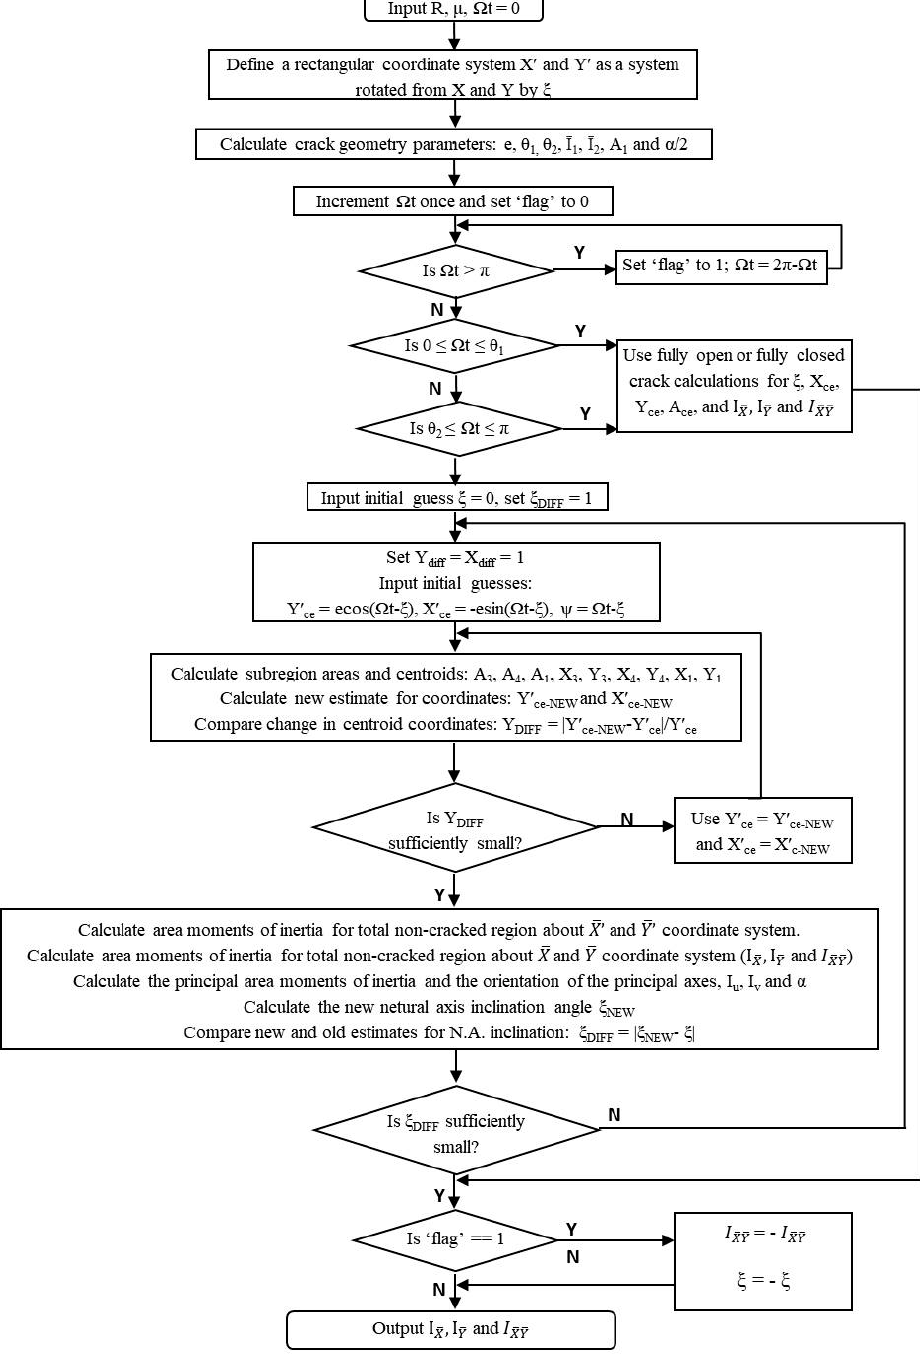
Figure A4. Decision flowchart for determining crack parameters based on shaft rotation angle.